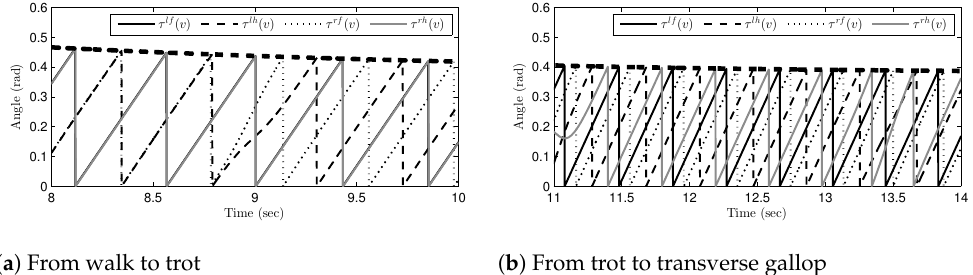
Figure 14. The desired time-intervals during gait phase transitions: ( a ) transitions from the walk phase to the trot phase and ( b ) transitions from the trot phase to the transverse gallop phase. Based on the calculated desired time-intervals, the scaled gait phase indexes can be obtained for the calculation of joint-angle trajectories, as shown in Figure 15.